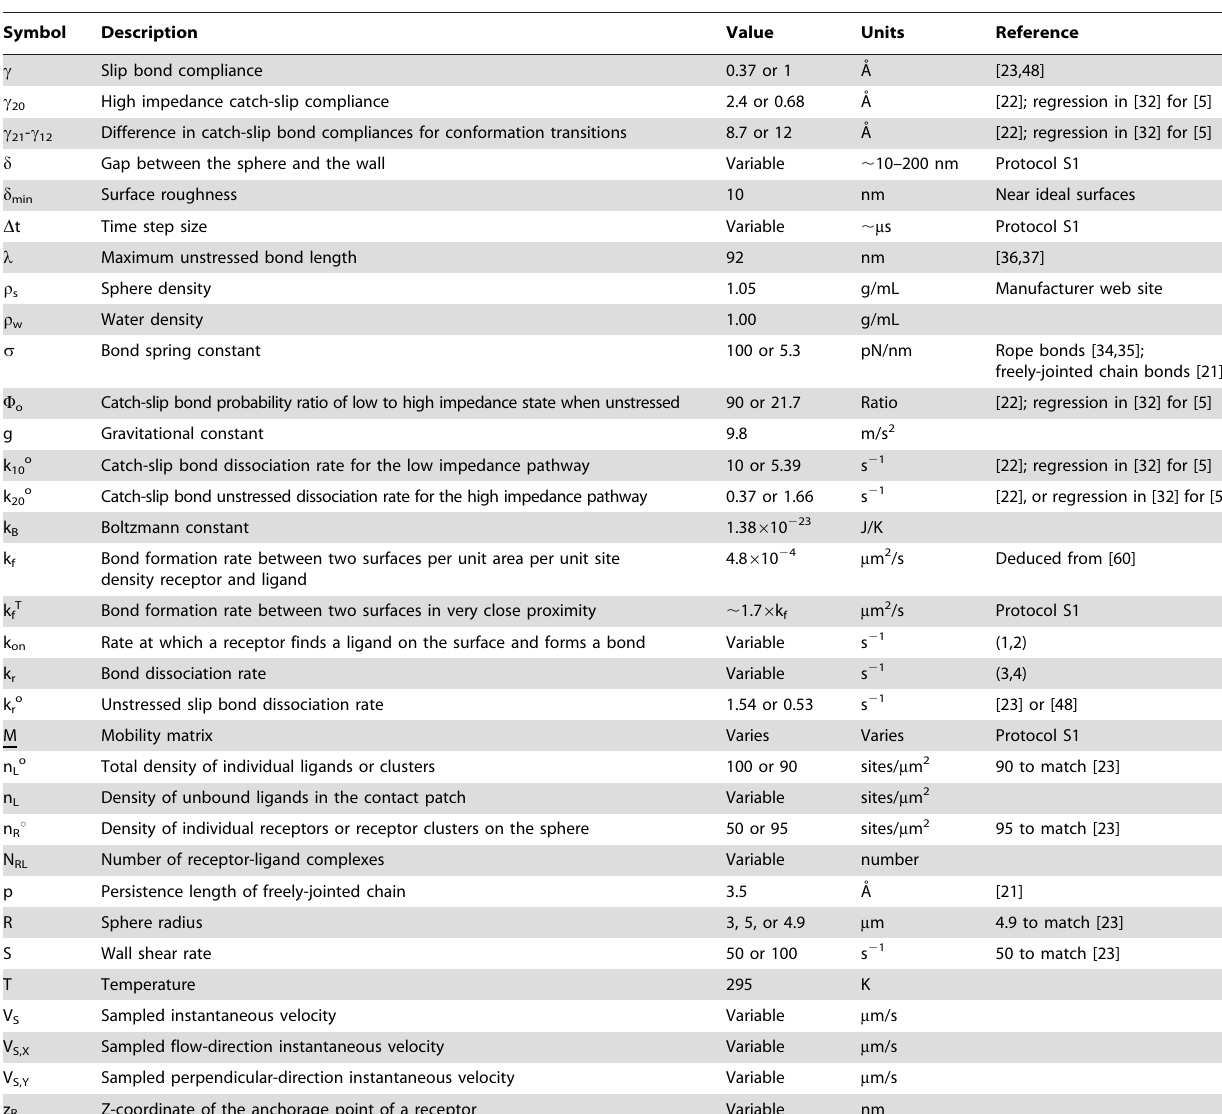
Table 1. Symbols used in the text and parameter values used in the simulation.